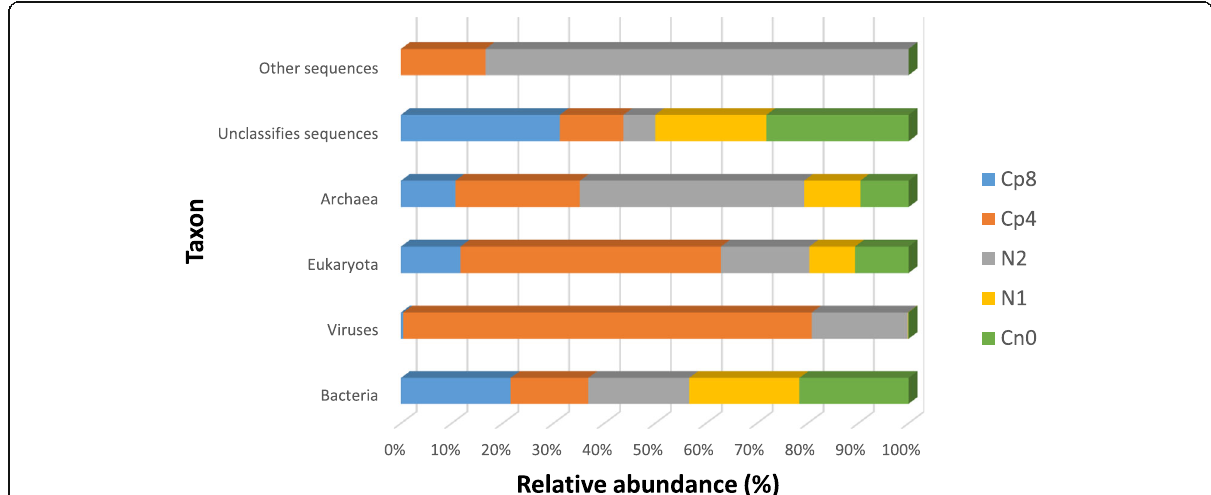
Fig. 3 The microbial taxa ’ s relative abundance at the domain level within maize rhizosphere soil samples. The treatment is compost 8 tons/ha (Cp8), compost 4 tons/ha (Cp4), inorganic N — 120 kg N/ha (N2), inorganic N — 60 kg/ha (N1), and control